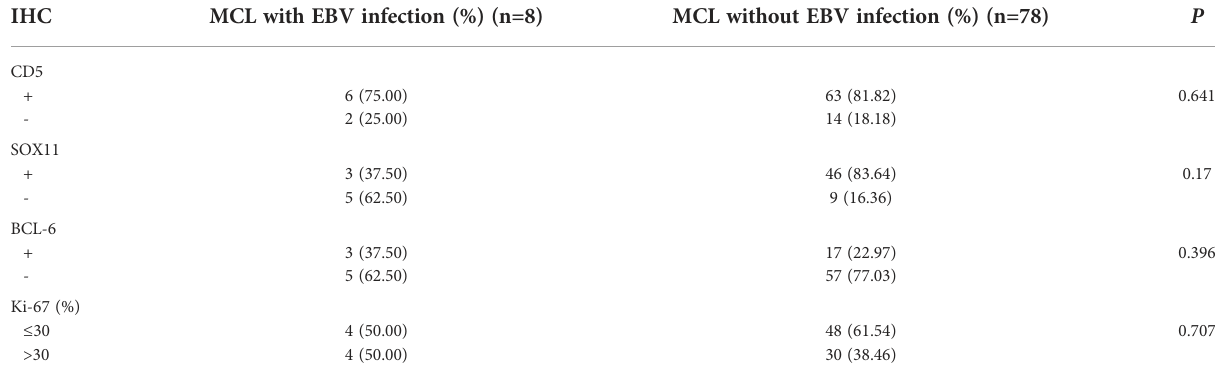
TABLE 3 Immunohistochemical comparison of patients with and without EBER